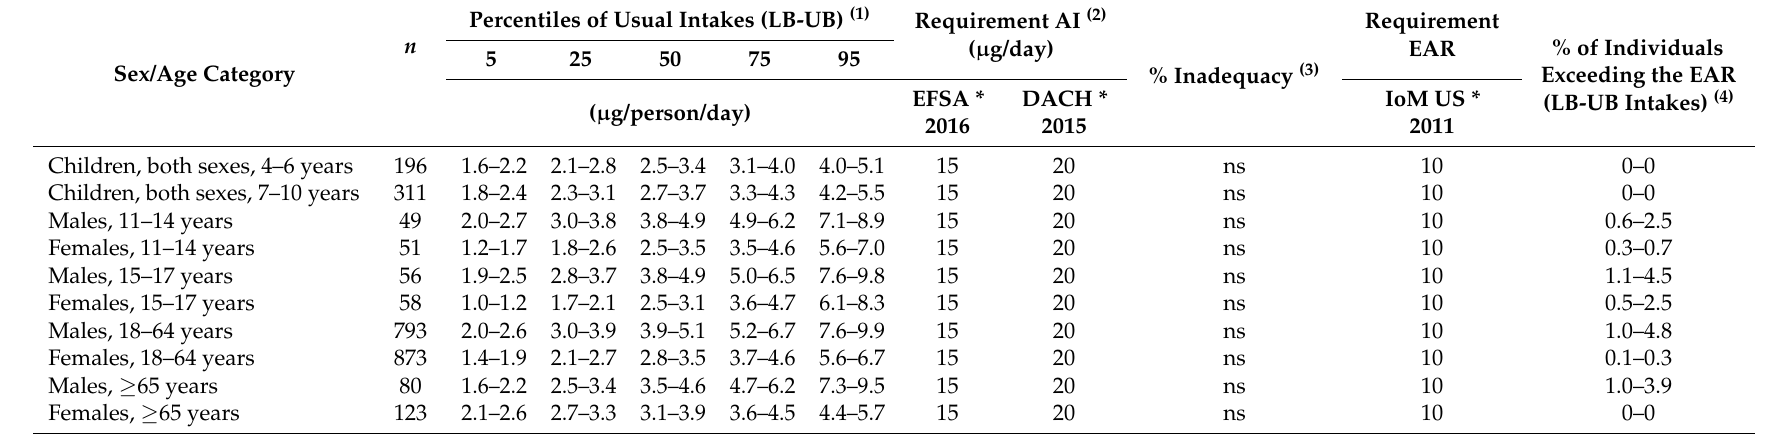
Table 2. Distribution of usual intake of vitamin D (sum of D 2 +D 3 in µ g/person/day) from total diet in 10 Czech population